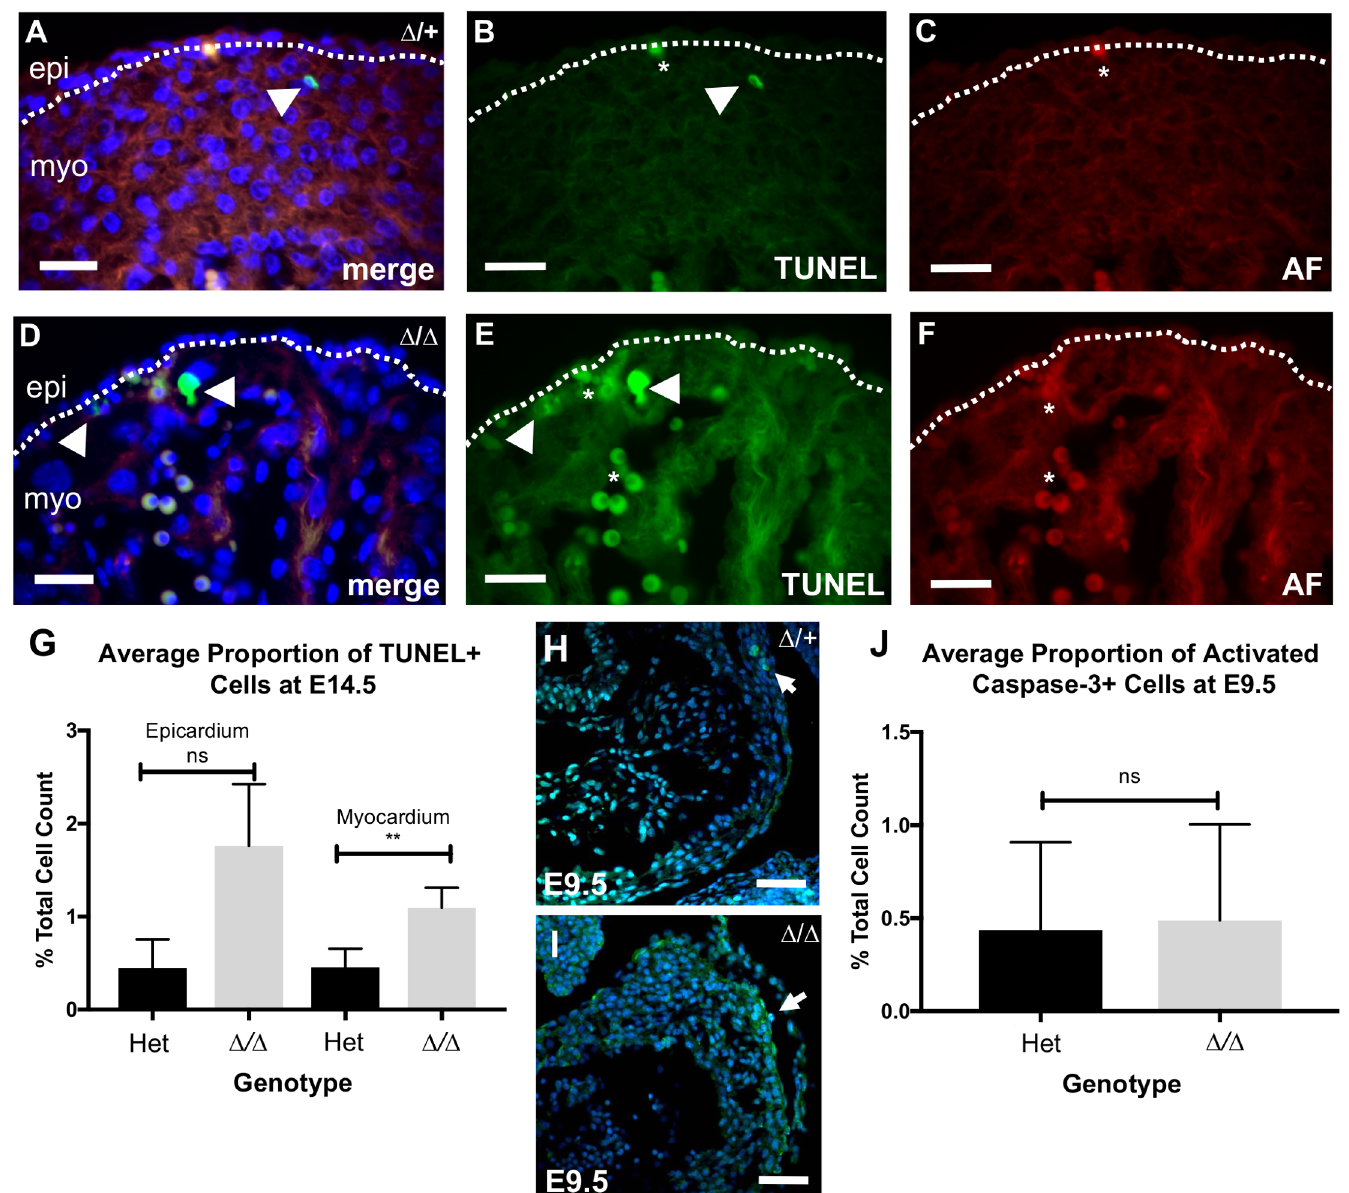
Fig 12. Apoptosis in Myh10 Δ mutant hearts. A: TUNEL analysis(green)of Myh10 Δ heterozygous heart at E14.5 shownwith nucleistained with DAPI (blue). B: Singlechannelof TUNEL stainingfrom (A). Apoptotic cells (arrowhead)are presentalong with autofluorescent erythrocytes (asterisk). C: Autofluorescenceof erythrocytes (red) from (A). D: TUNEL analysis(green)of Myh10 Δ homozygous mutant heart at E14.5 shownwith nucleistained for DAPI (blue). E: Singlechannelof TUNEL stainingfrom (D). Apoptoticcells (arrowhead)are present alongwith clusters of erythrocytes (asterisks). F: Autofluorescenceof erythrocytes (red) from (D). G: Graph comparingmean numberof TUNEL positivecells as a proportion of total cells in either the epicardium, or myocardial wall. Meanpercentage of apoptosisin control = 0.4484%(+/- 0.3082%),and mutant epicardium = 1.762%(+/- 0.662%)(unpaired 2-tailedMann-Whitney U-test, p = 0.0744).Mean percentage of apoptosisin control= 0.4532%(+/- 0.204%), andmutant myocardial wall = 1.097% (+/- 0.2132%) (unpaired 2-tailedMann-Whitney U-test, p = 0.0053).Three hearts per genotypeand six non-consecutive sectionsper heart wereanalysed.H: Sagittal sectionof control and I: Myh10 Δ homozygous mutant hearts at E9.5 showingimmunofluorescencefor activated Caspase-3 (turquoise, arrows), with nucleivisualisedwith DAPI (blue). J: Graph comparingmean number of activated caspase-3 positivecells as a percentage of total cells in cardiacsectionsof controland mutant E9.5 hearts. Meanpercentage of apoptosisin control = 0.435%(+/- 0.0.1579%), and mutant hearts = 0.4885%(+/- 0.1722%).Three hearts were examinedper genotype,and three sectionswere analysedfor each heart. There is no significantdifferencein apoptosisbetweenthe two genotypes (unpaired2-tailedMann-Whitney U-test, p = 0.9292). Error bars in G and J representstandard error of the mean. Scale bars: A-F = 25 μ m, H-I = 50 μ m.